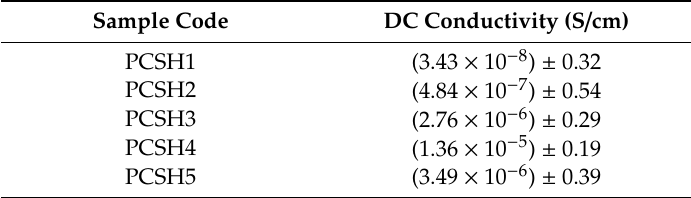
Table 2. The DC conductivity value of PVA / CS / xNH 4 SCN